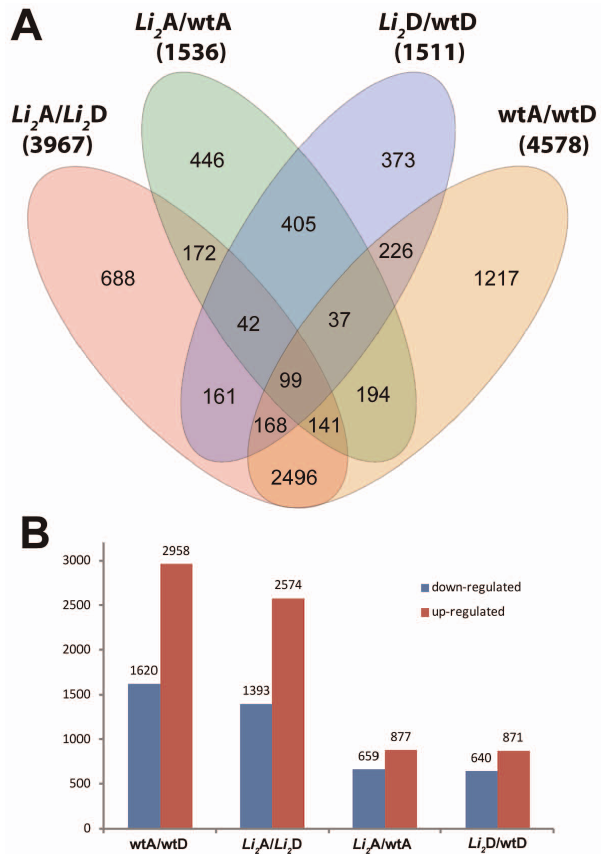
Figure 1. Overview of significantly regulated genes in devel- oping fiber of Li 2 NILs across all comparisons. (A)Venn diagram of regulated genes in Li 2 versus wild type in A T /D T subgenomes. Total number of significantly regulated genes in each comparison is indicated in parentheses. (B) The chart represents up- and down- regulated genes between subgenomes and fiber type comparisons.